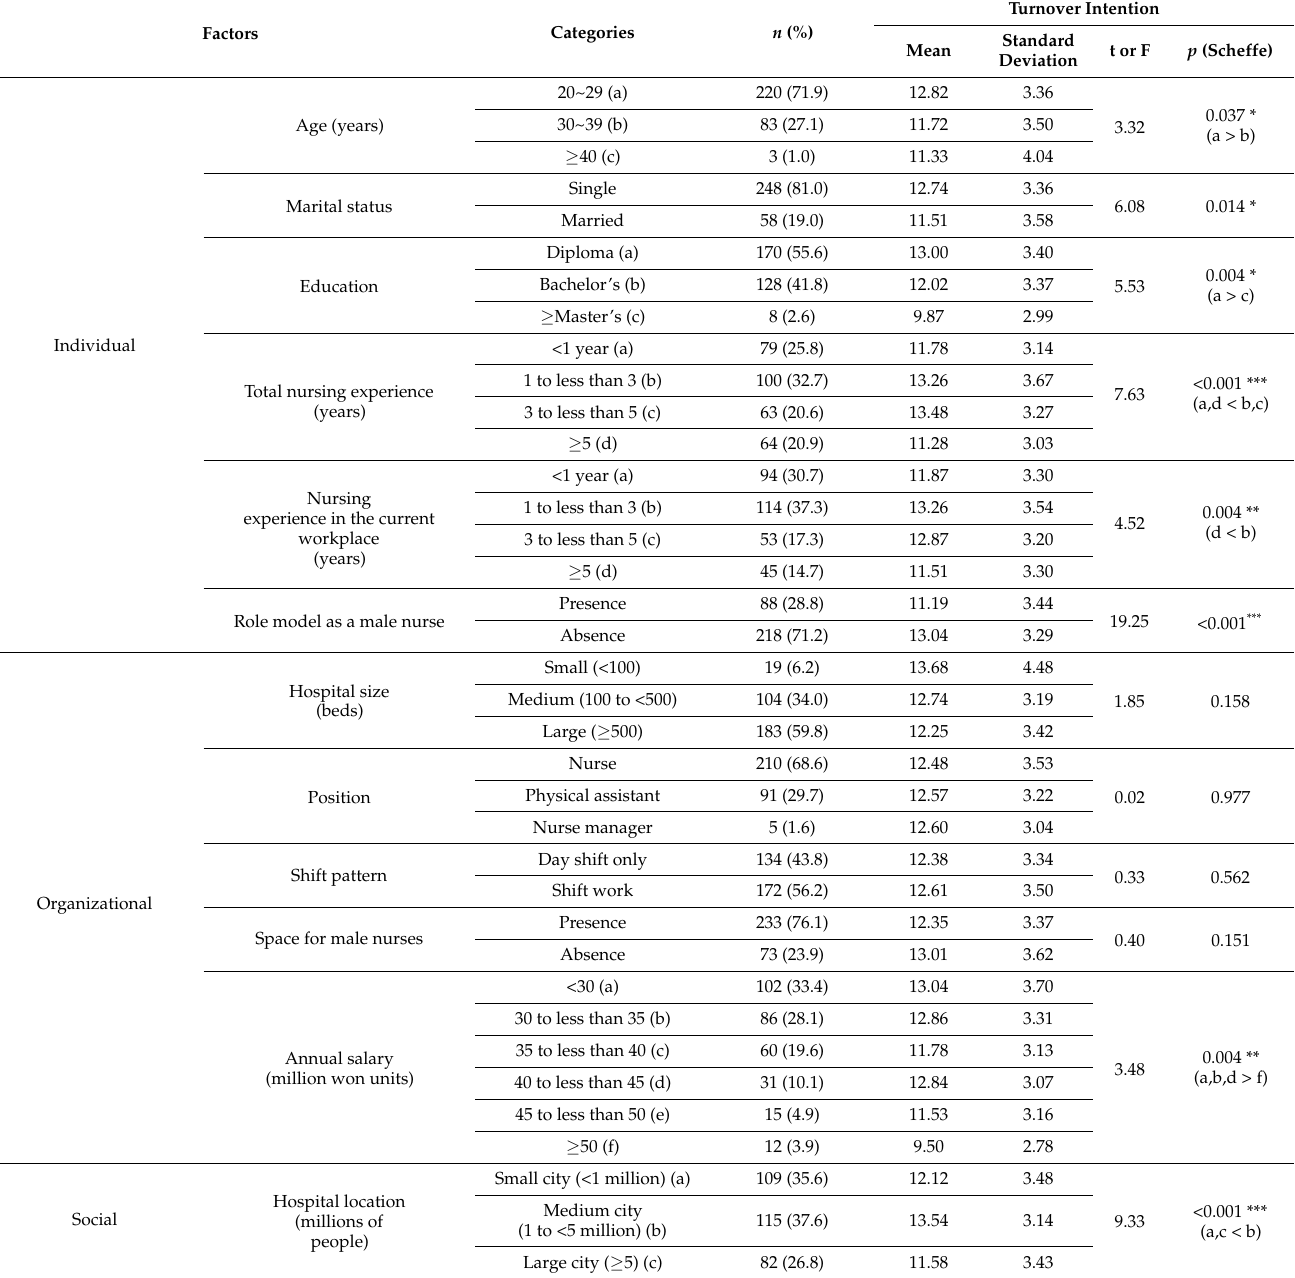
Table 1. General characteristics and differences in turnover intention ( N =